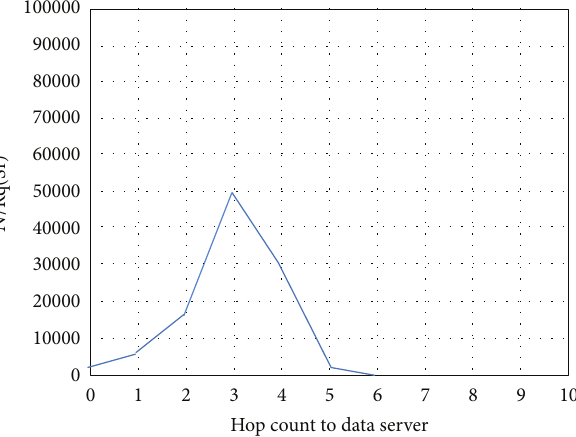
Figure 8: Comparison of service request from local storage with third probability set.